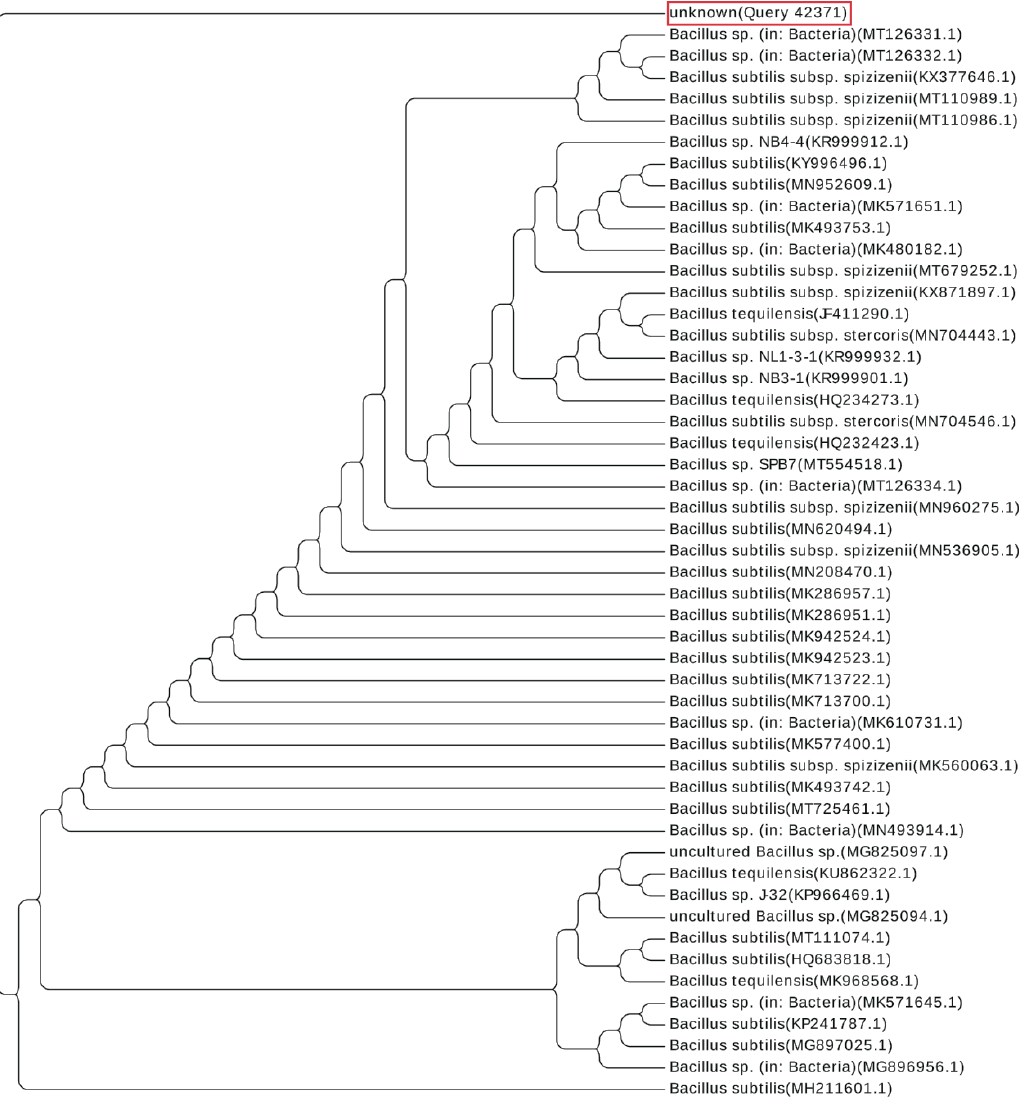
Figure 3. Phylogenetic tree based on the similarity of 16S rRNA genes showing that the BS-40 strain (red outline) is closely related to a subspecies of Bacillus subtilis .